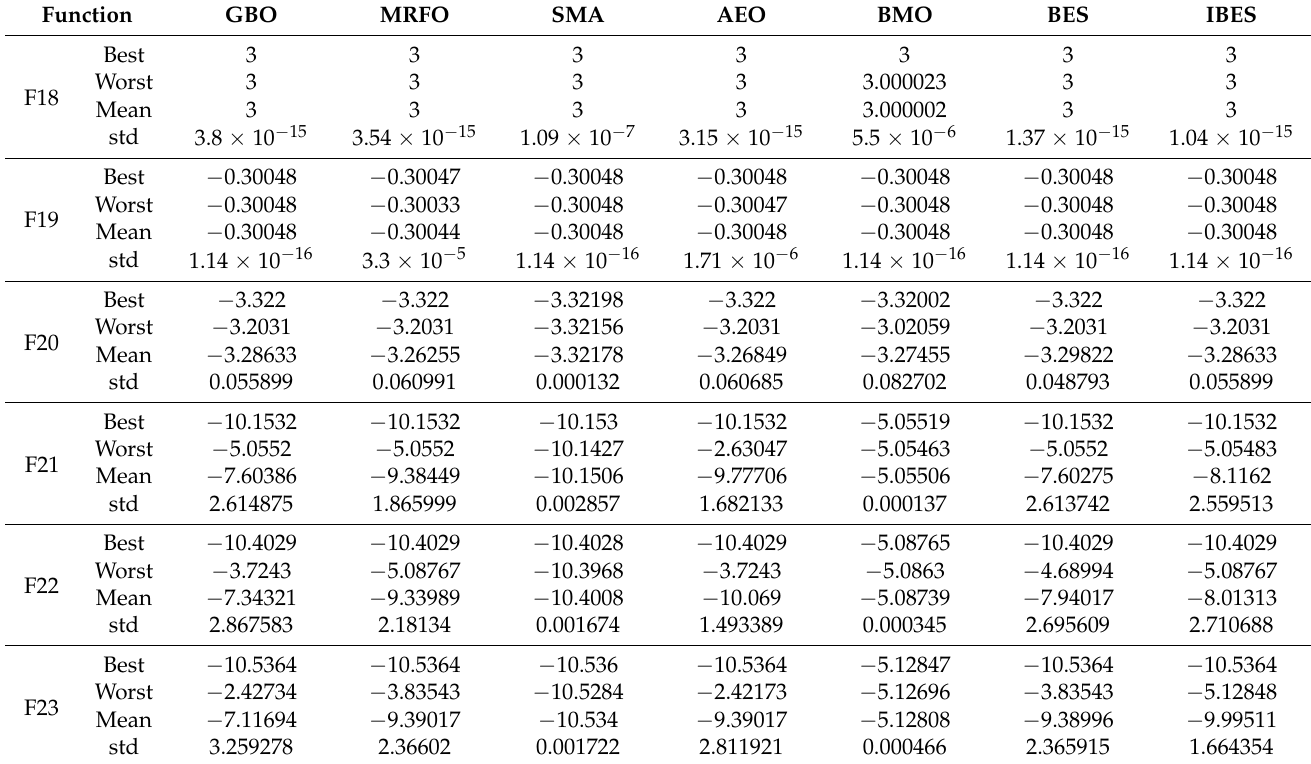
Table 5. The percentages of the best results compared to the total statistical results for unimodal, multimodal, and composite functions for all algorithms.